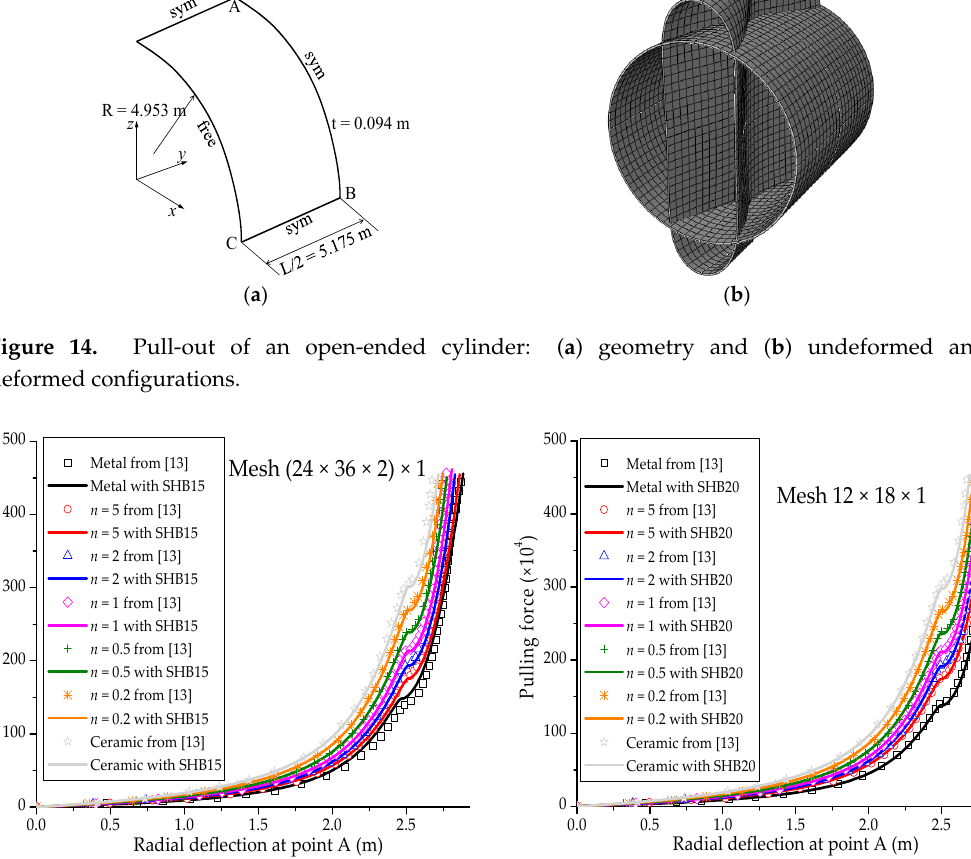
Figure 15. Radial displacement at point A under concentrated force for the open-ended cylinder. ( a ) Prismatic SHB15 element; ( b ) hexahedral SHB20 element.